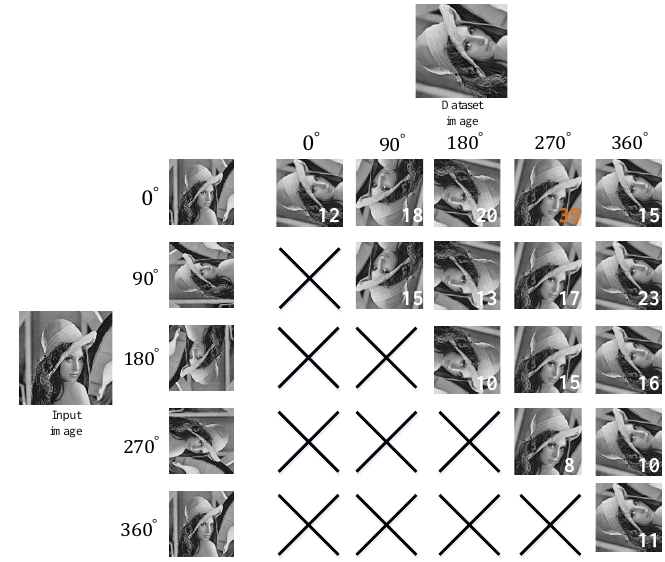
Figure 16. Illustration of the voting lookup table mechanism.